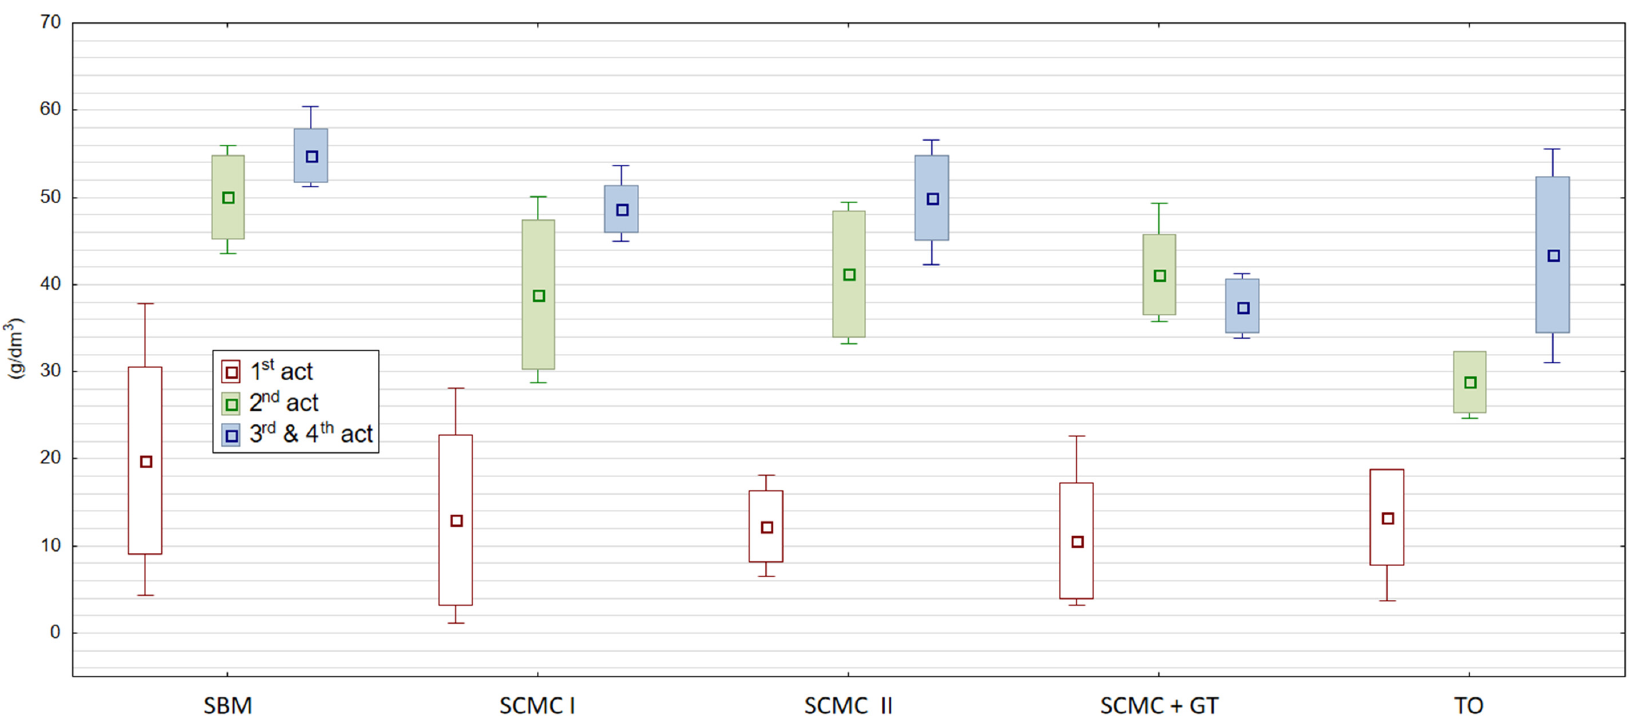
Figure 3. Dynamic activity in relation to C 6 H 6 of activated carbons after individual (1, 2, 3 and 4) activation series (g / dm 3 ). Source: own elaboration. 1st act—first activation series, 2nd act—second activation series, 3rd and 4th act—third and fourth activation series, carb—carbonization.